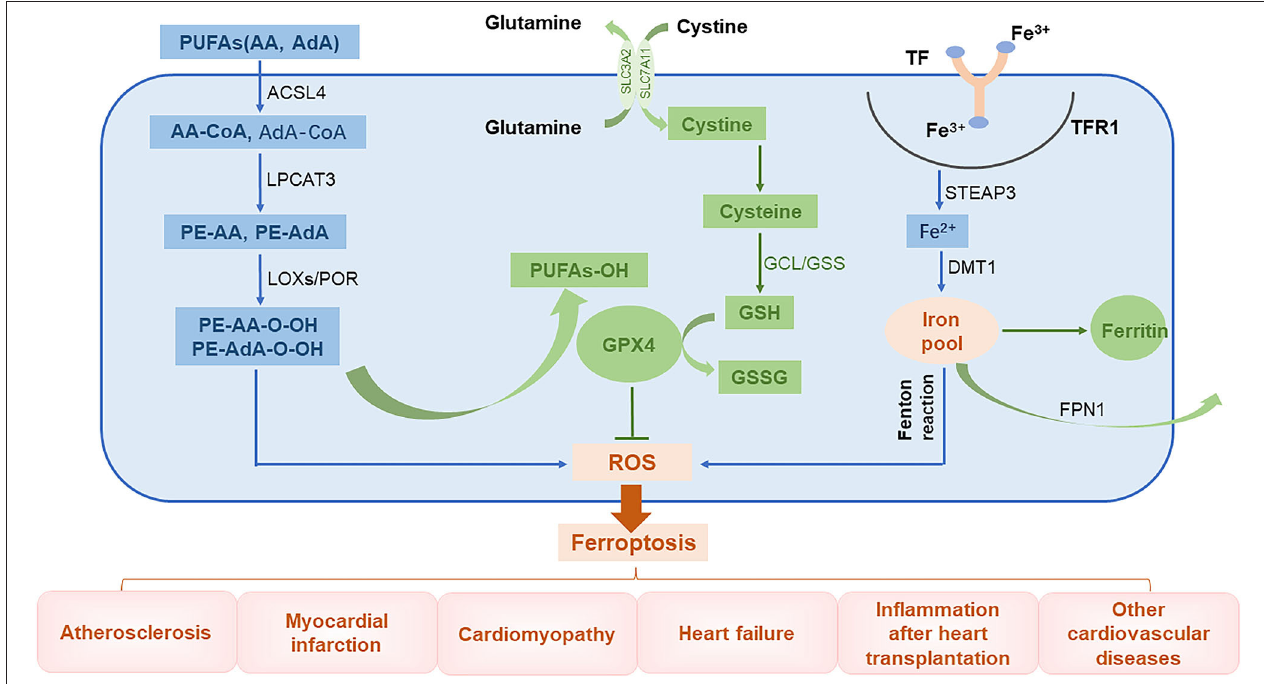
FIGURE 2 | The role of ferroptosis in the pathophysiology of CVDs. PUFAs, polyunsaturated fatty acids; AA, arachidonic acid; AdA, adrenal acid; ACSL4, long-chain fatty acyl-CoA synthase 4; LPCAT3, lysolecithin acyltransferase 3; LOXs, lipoxygenases; POR, cytochrome P450 oxidoreductase; GCL, glutamate-cysteine ligase; GPX4, glutathione peroxidase 4; TF, transferrin; TFR1, transferrin receptor 1; Steap3, six-transmembrane epithelial antigen of prostate 3; DMT1, divalent metal transporter 1; FPN1, ferroportin 1.